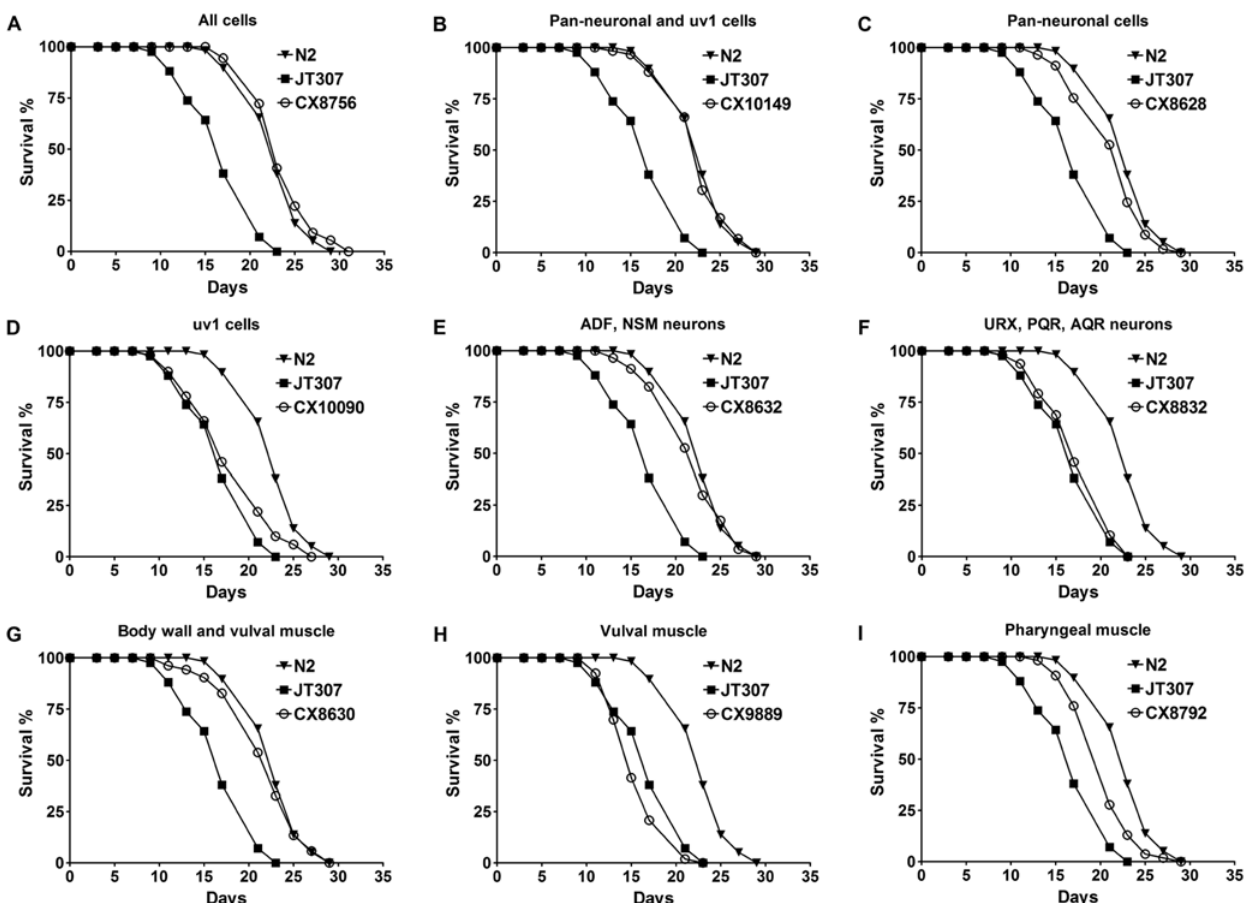
Figure 5. HIF-1 functions in specific neurons and muscles to regulate lifespan extension by DR. Lifespan of wild-type N2, JT307 egl- 9(sa307) and egl-9 animals with various tissue-specific promoters driving egl-9 cDNA (CX strains) was measured under DR to determine the tissues where expression of egl-9 rescues the lack of full lifespan extension by DR. Tissues where egl-9 expression is restored were (A) all cells, (B) pan- neuronal and uv1 cells, (C) pan-neuronal cells, (D) uv1 cells, (E) ADF, NSM neurons, (F) URX, AQR, PQR neurons, (G) body wall and vulval muscles, (H) vulval muscle, and (I) pharyngeal muscle. Each of the lifespan experiments was performed twice with consistent results. Quantitative data and statistical analyses for the experiments shown here and the repeated experiments are included in Table 3 and Table S3,